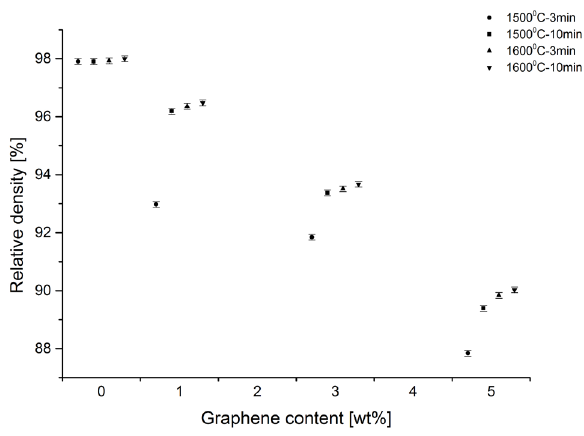
Figure 4: Relative density as a function of graphene content.